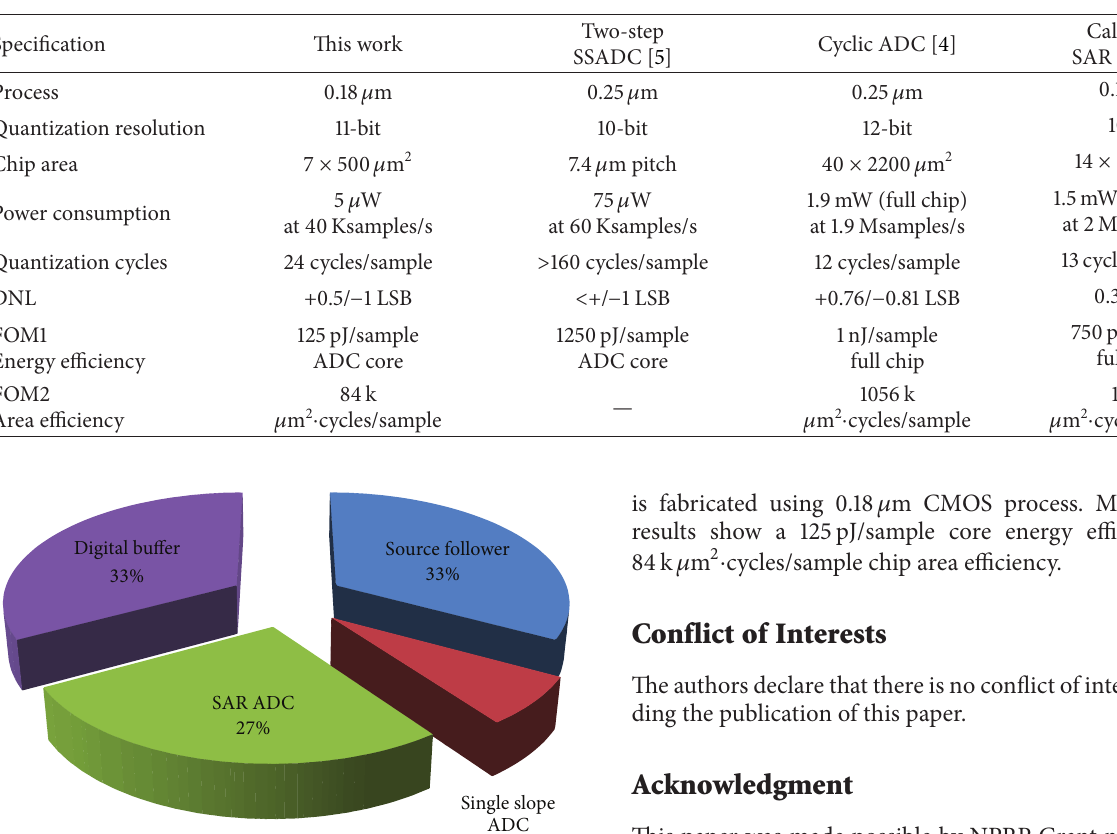
Table 1: The summarized comparison with other types of column-parallel architectures.